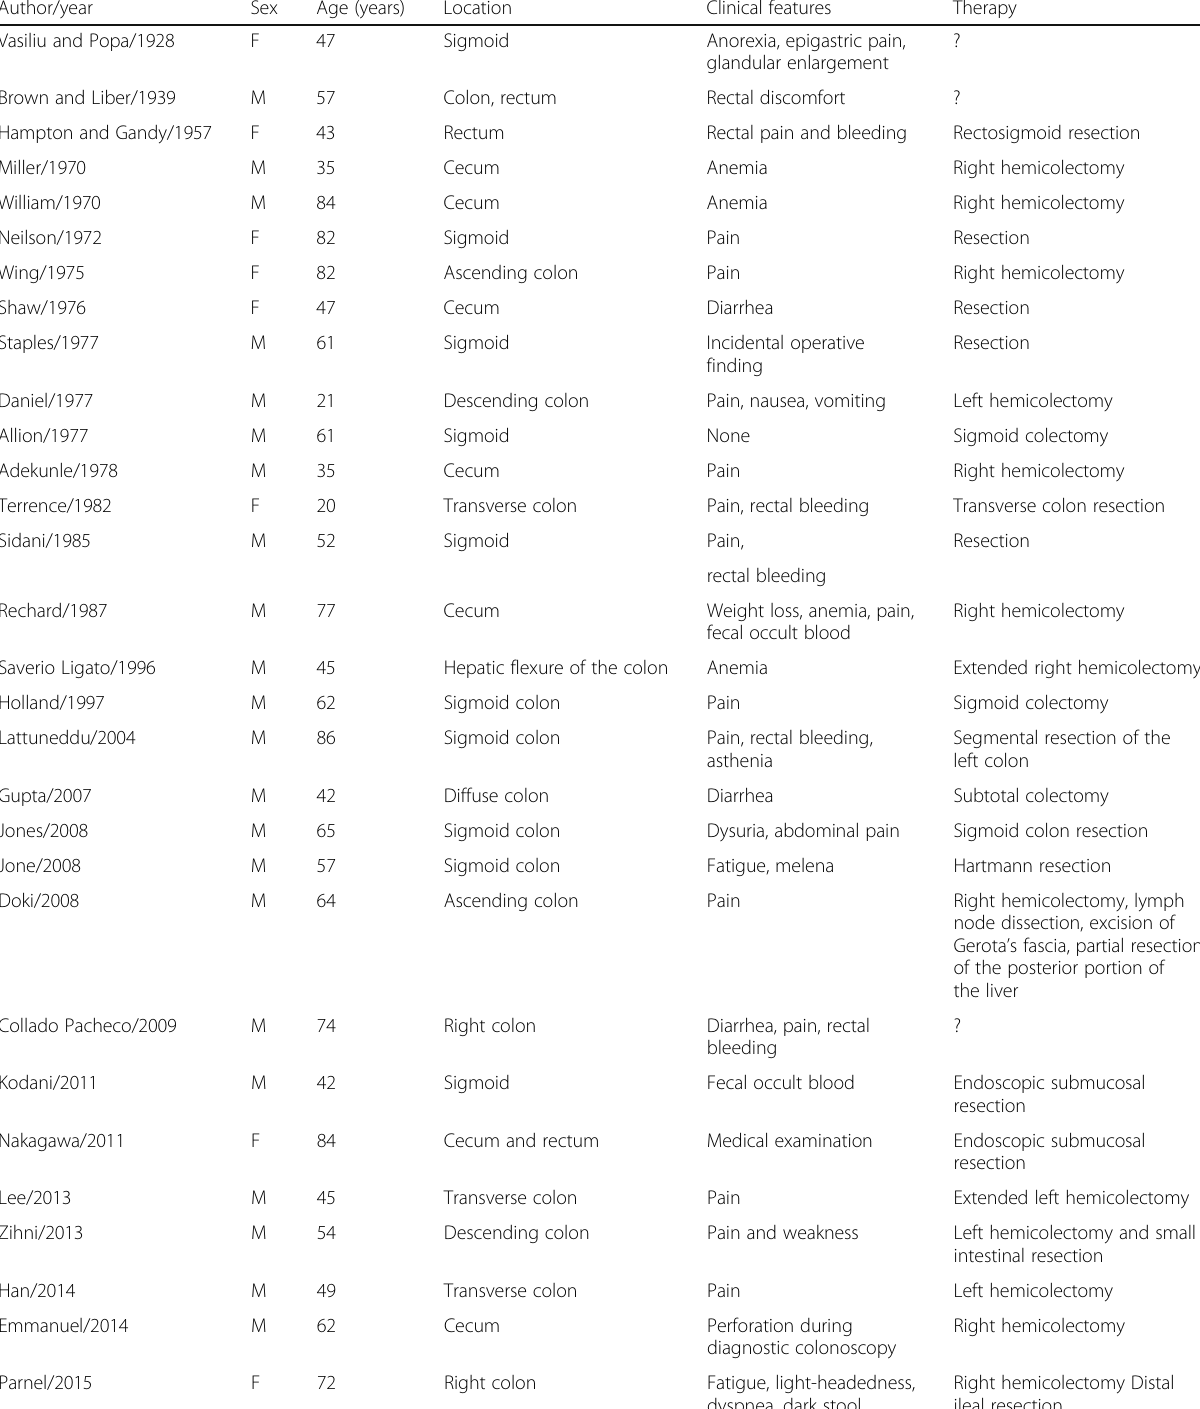
Table 2 Well-documented cases of plasmacytoma of the